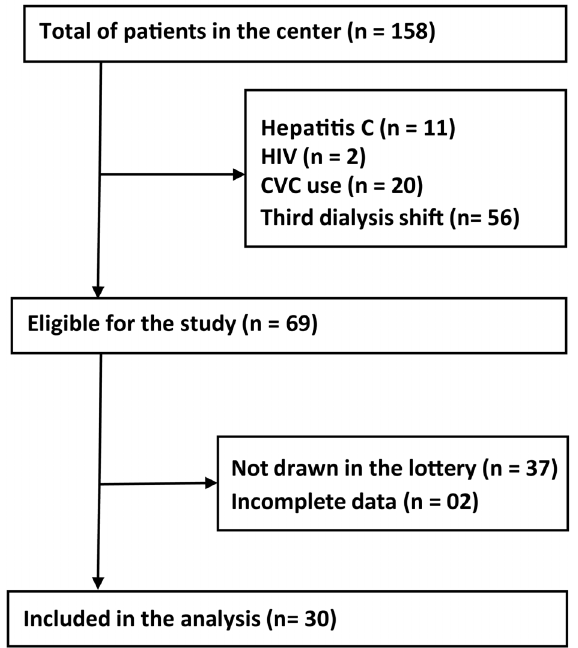
Figure 1. Selection of study participants. HIV: Human immuno- de fi ciency virus; CVC: central venous